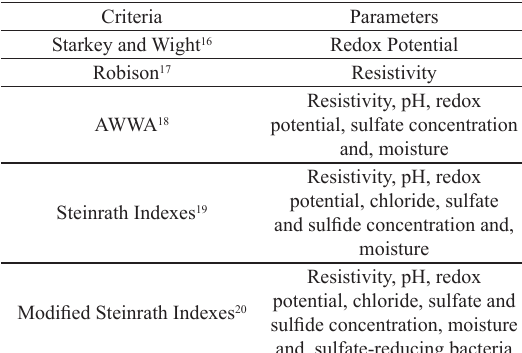
Figure 1. Flowchart of the work steps. Table 1. Most common criteria for soil